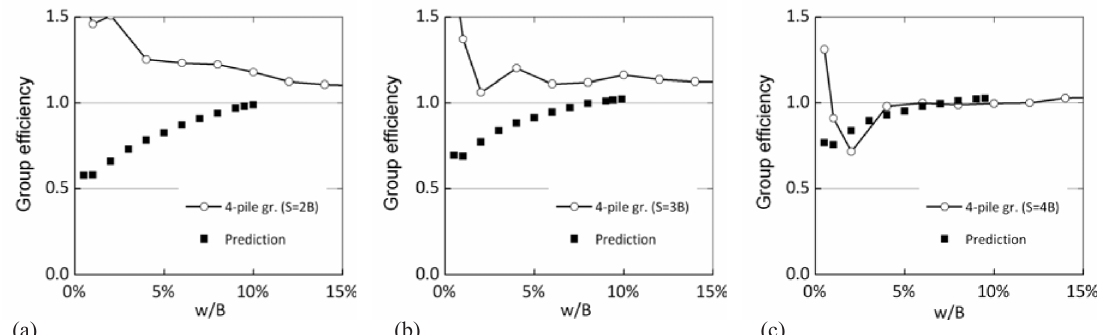
Fig. 22. Comparison of group efficiency calculated for measured and predicted pile group response in medium dense sand for different pile spacings: (a) S/B = 2; (b) S/B = 3; (c) S/B =